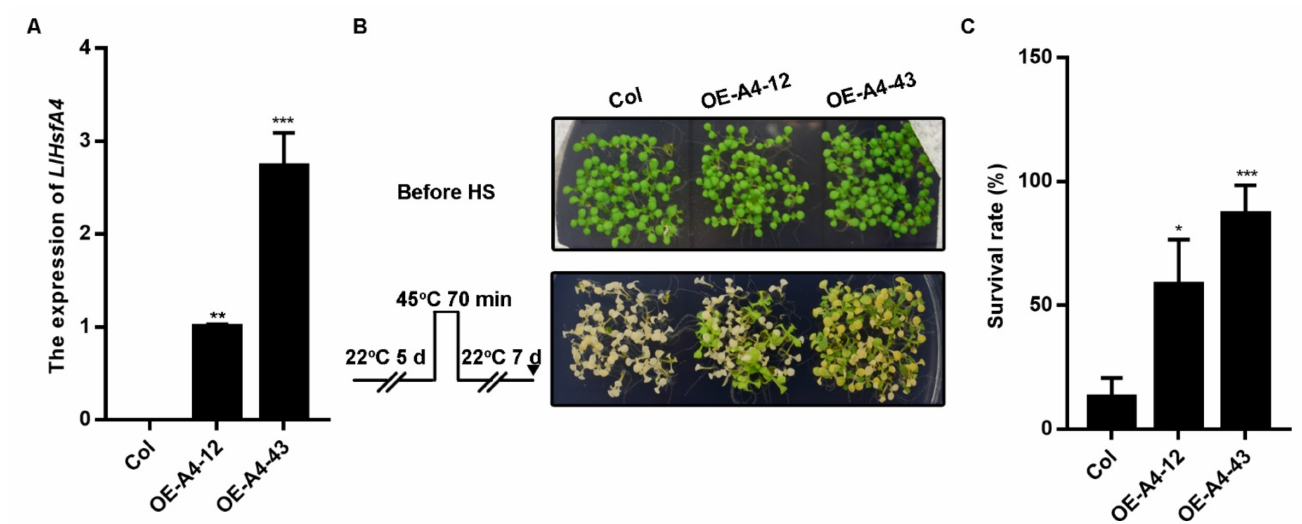
Figure 6. Transgenic Arabidopsis plants of LlHsfA4 enhanced basal thermotolerance. ( A ) Overexpres- sion of LlHsfA4 in transgenic lines was examined using qRT-PCR. ( B ) Images of two transgenic lines and the wild type (Col) under normal conditions and recovery for 7 d after heat stress. ( C ) Survival rates of transgenic lines were calculated in ( B ). t -test analysis of variance was employed to identify treatment means that differed statistically.Samples with different letters are significantly different: * p < 0.05, ** p < 0.01, *** p <